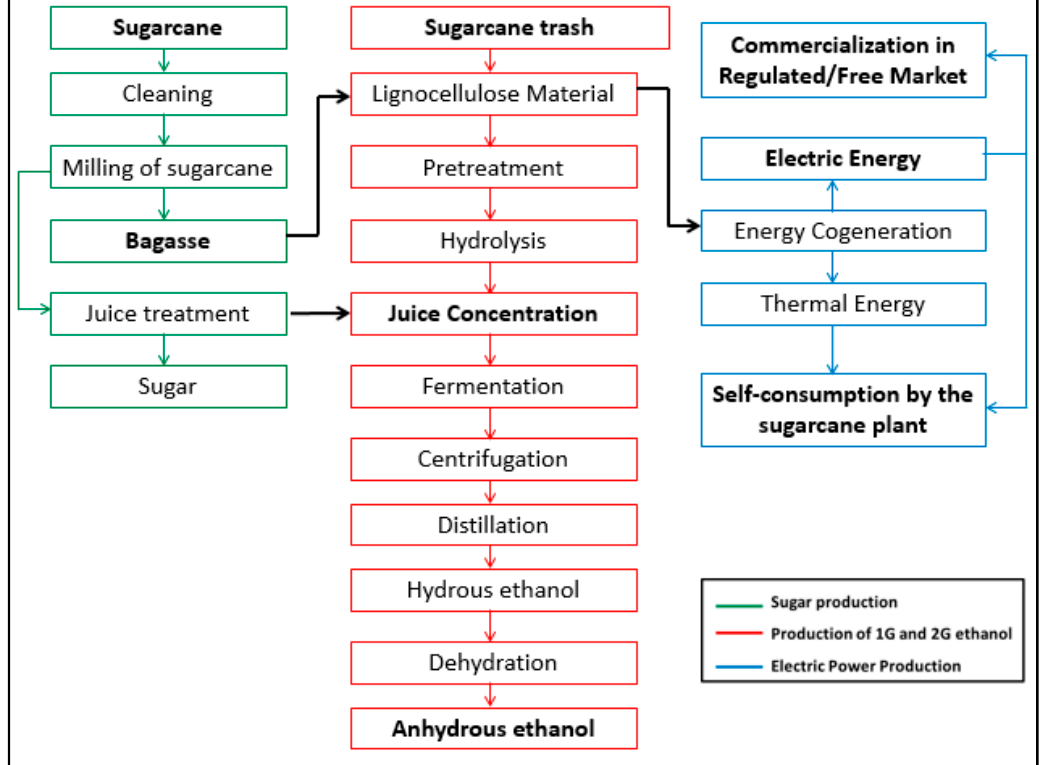
Figure 1. Flow chart of the production process in a sugarcane plant. Source : Own elaboration.